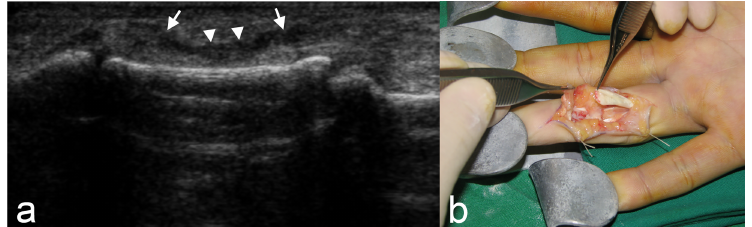
Fig 1. A 23-year-old man with a flexor digitorum profundus tendon rupture of the ring finger. (a) Ultrasound image of longitudinal scan shows discontinuity of the tendon with retraction of the ruptured tendon (arrows) at the middle phalangeal level. Decreased echogenicity of the ruptured tendon site is also seen (arrowheads). (b) On surgery, the rupture of the flexor digitorum profundus tendon was confirmed and picked up with